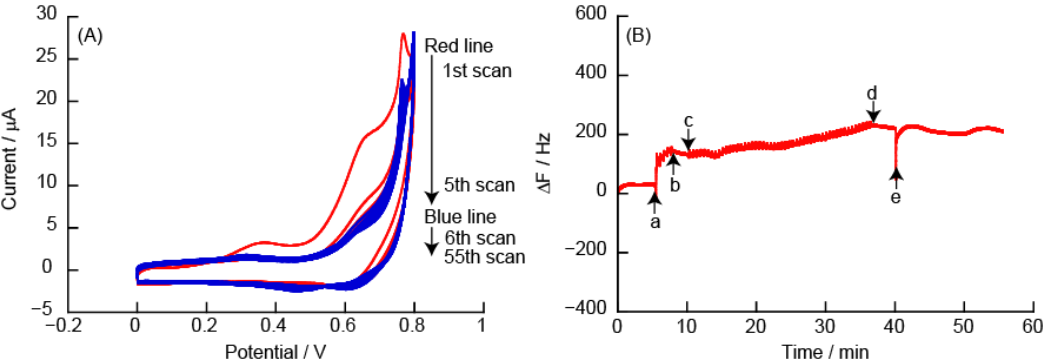
Figure 9. ( A ) Cyclic voltammograms of (PDDA/TEMPO-PAA) 5 film in 10 mM HEPES (pH 7, con- taining 150 mM NaCl), and ( B ) changes in the resonance frequency on the Au resonator in eQCM. The electric potential (scan rate: 50 mV/s) was applied between (a) and (b) (number of sweep scan: 5 times), or (c) and (d) (number of sweep scan: 50 times) in the eQCM. Finally, the Au resonator was exposed to 10 mM HEPES buffer (pH 7, containing 150 mM NaCl) (e).